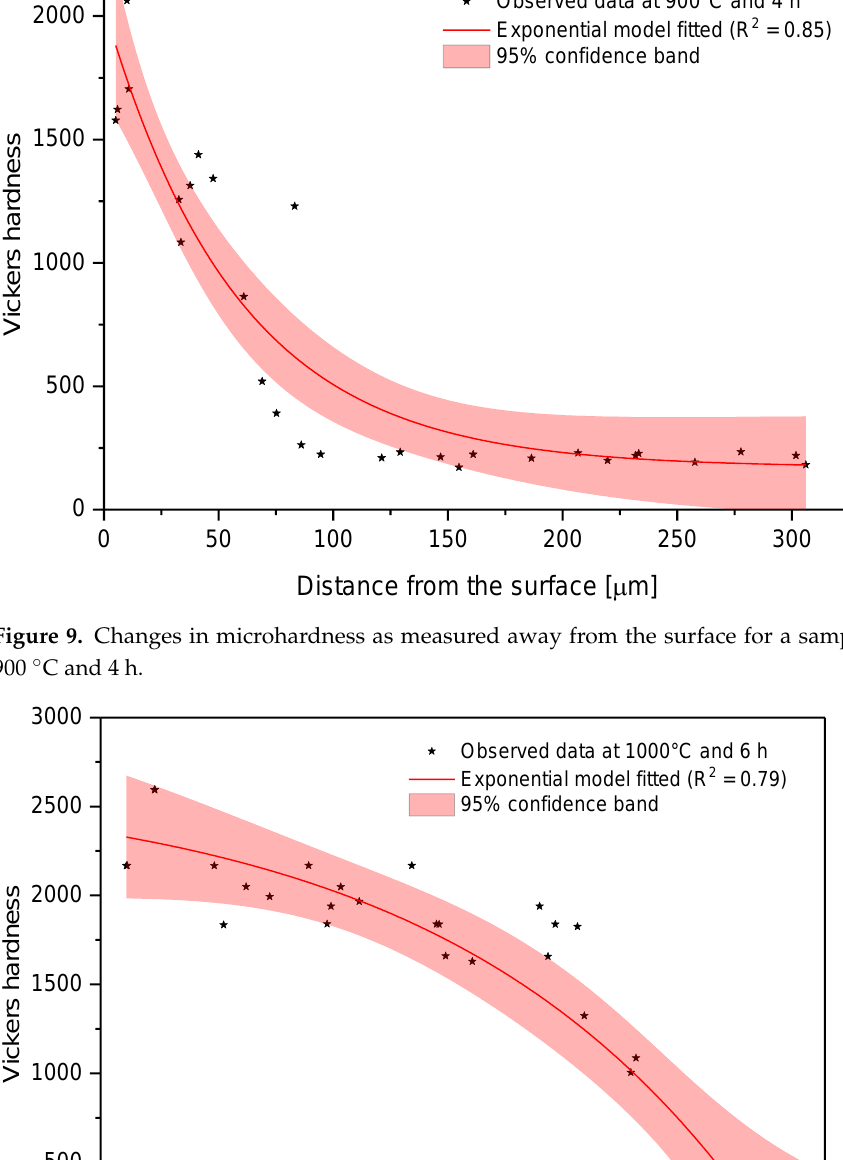
Figure 8. Changes in microhardness as measured away from the surface for a sample treated at 850 °C and 2 h.